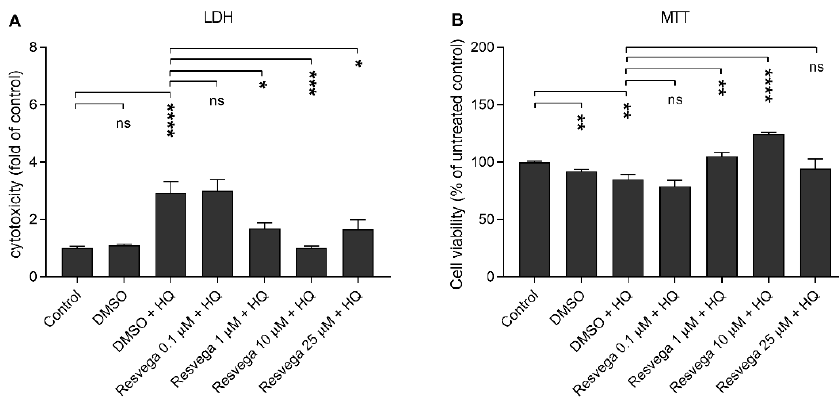
Figure 2. The effect of Resvega (DMSO 0.5% v / v ) on the viability of ARPE-19 cells upon hydroquinone (HQ) exposure. The viability of untreated control cells were set to be 1 in case of LDH ( A ) and 100% in MTT ( B ), to which other groups were compared. The results are combined from three independent experiments with four parallel samples per group in each experiment and shown as mean ± SEM. * p < 0.05, ** p < 0.01, *** p < 0.001, **** p < 0.0001, ns—not significant, Mann-Whitney U-test.